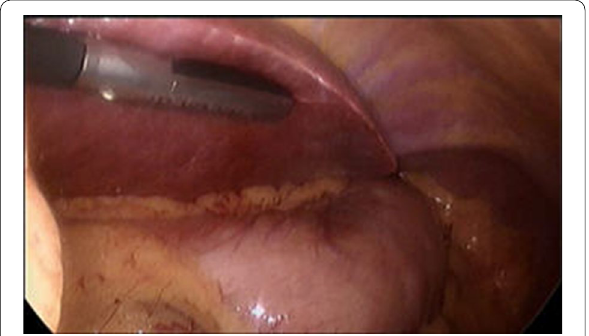
Fig. 5 IOUS for HCC near bowel and glucose 5% to protect